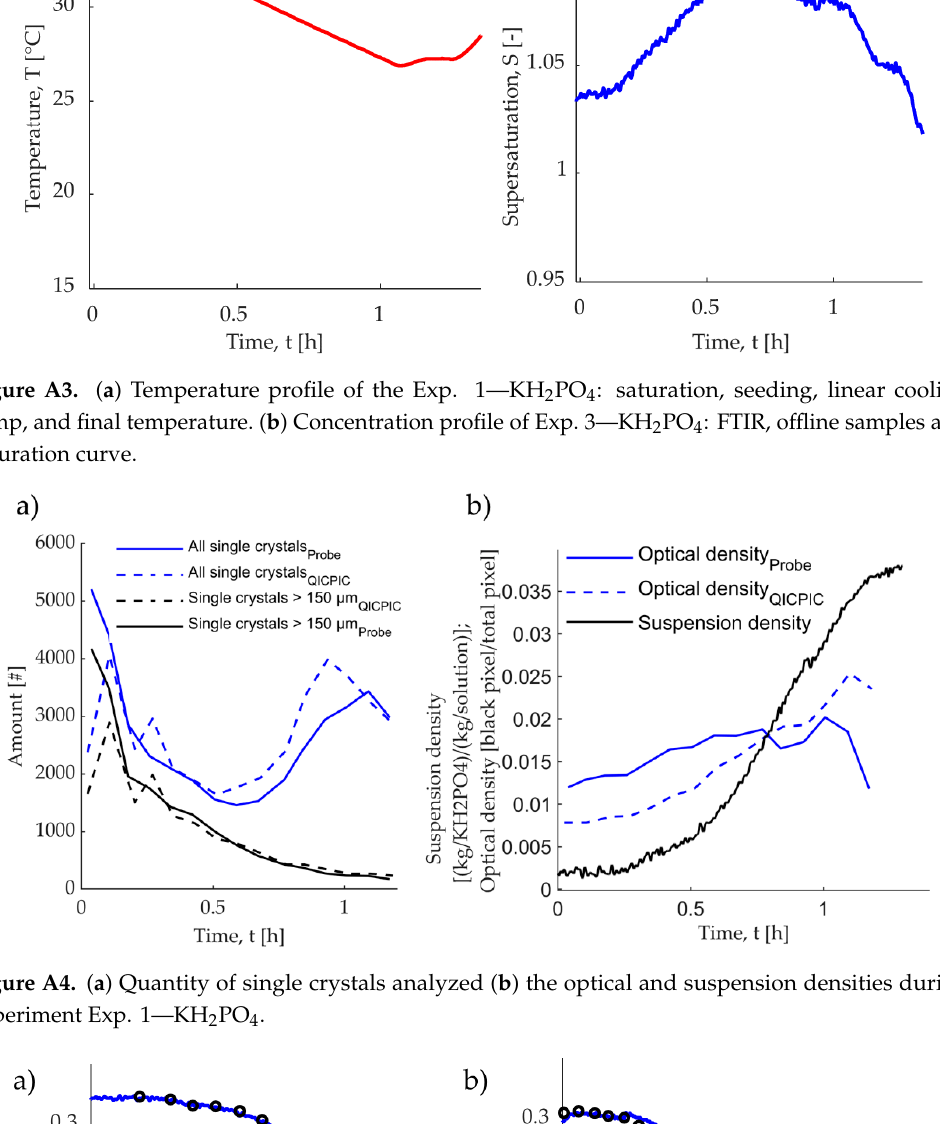
Figure A2. ( a ) Percentiles and mean values of the crystal size distributions for Exp. 1 - KH 2 PO 4 t hin lines - percentiles of the q 0- distribution; bold lines – percentiles of the q 3 -distributions; Solid lines - percentiles and mean values shadowgraphic probe; Dashed lines - percentiles and mean values QICPIC; brown; magenta − 0.15 and 0.85 percentile of the corresponding distribution; blue - mean size of the corresponding distribution. ( b ) Comparison of the mass distribution: shadowgraphic probe, QICPIC, sieve analysis.